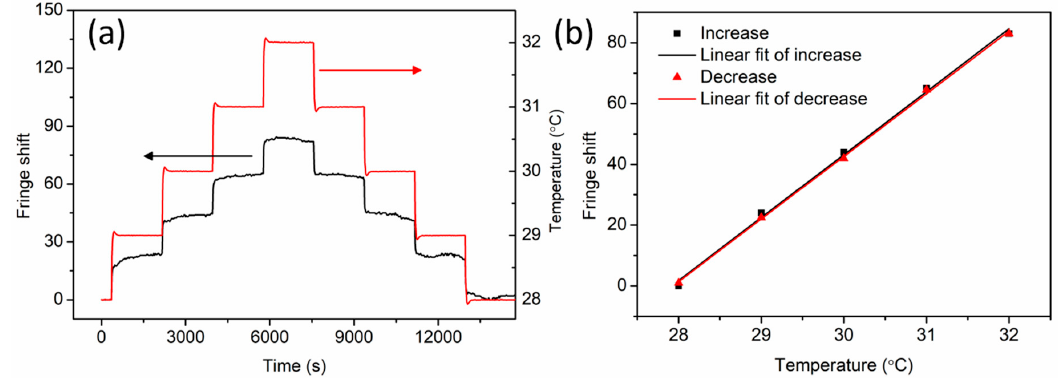
Figure 8. ( a ) Fringe and temperature variation as a function of time and ( b ) linear fit of fringe shift versus temperature (increase and decrease) one month after PC mPOF annealing at 125 °C for 36 h.